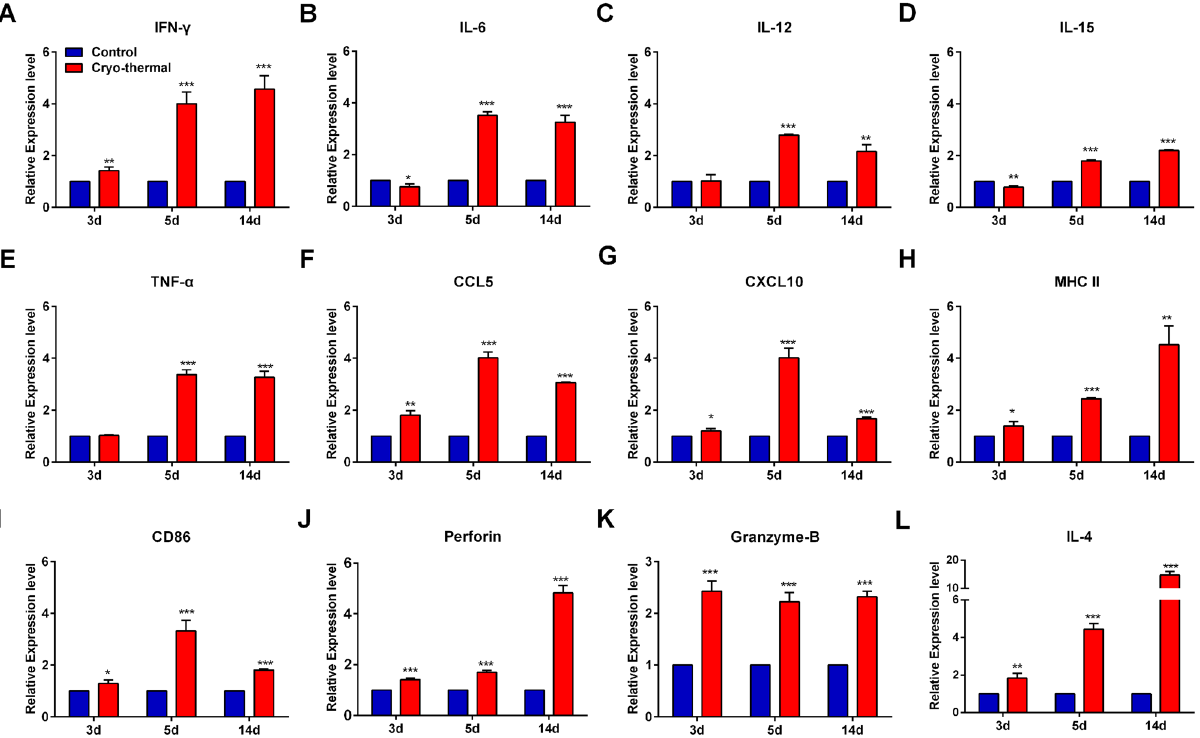
Figure 2. Cryo-thermal therapy induced the activation of eosinophils. Total RNA was isolated from splenic Siglec-F + eosinophils in cryo-thermal-treated mice on day 3, 5 and 14 after the treatment. The mRNA in splenic Siglec-F + eosinophils from tumour-bearing mice on day 15, 17 and 26 after tumour inoculation was used as control. The expression level of IFN- γ ( A ), IL-6 ( B ), IL-12 ( C ), IL-15 ( D ), TNF- α ( E ), CCL5 ( F ), CXCL10 ( G ), MHC II ( H ), CD86 ( I ), Perforin ( J ), Granzyme-B ( K ) and IL-4 ( L ). Data was shown as mean ± SD. Data for bar graphs was calculated using student’s t-test. * p < 0.05; ** p < 0.01; *** p < 0.001.